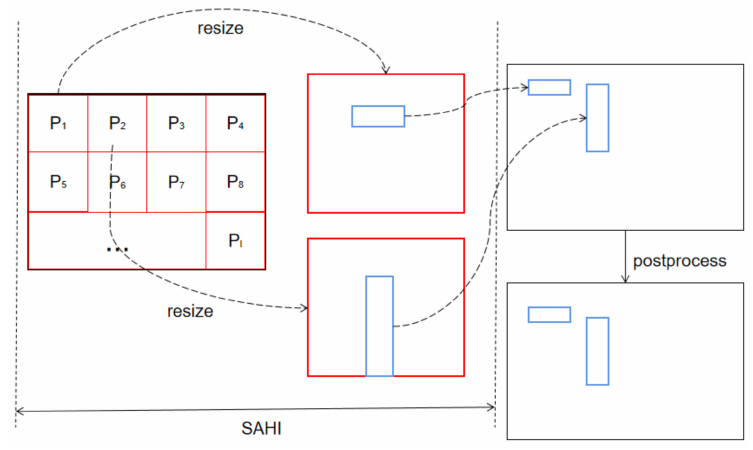
Figure 7. Execution process of the SAHI